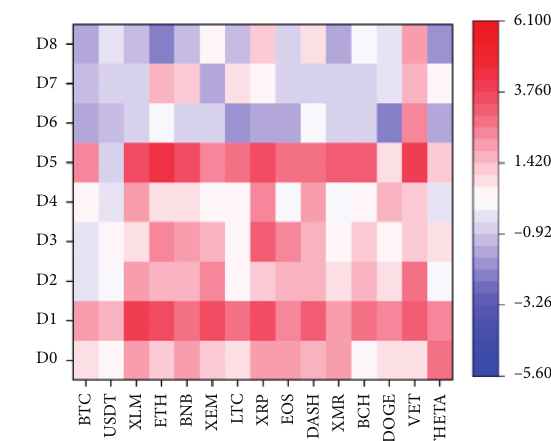
Figure 24: LINK to the other.